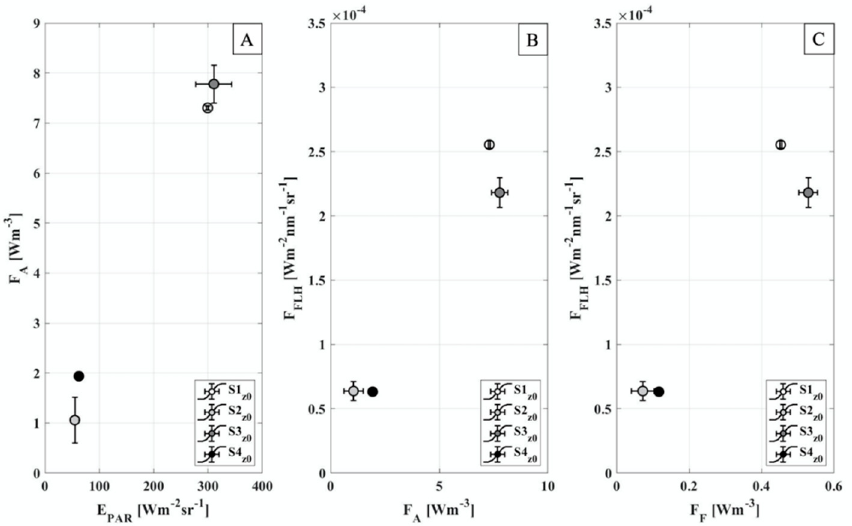
Figure 5. ( A ) shows the comparison between the E PAR and the F A evaluated with Equation (6); ( B ) the comparison between F A and the fluorescence proxy evaluated with Equations (11) and (12); ( C ) shows the comparison between the fluorescence proxy F FLH and the fluorescence evaluated from the water samples exploiting Equation (7). Values displayed corresponds to measurements evaluated at the surface. The colors (gray scale) help to discern between the several samples considered. All the measurements displayed here correspond to mean values, while the error bars to the standard deviations.